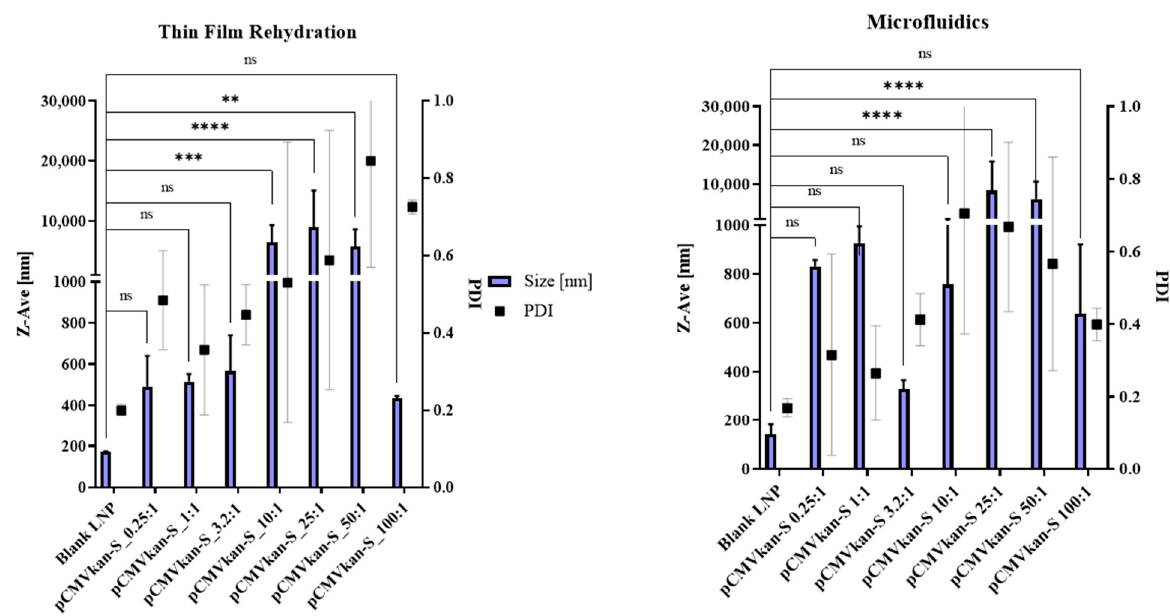
Figure 4. Size and size distribution of DOTAP4/pCMVkan-S complexes at different N/P ratios. Left graph shows the results obtained with thin-film layer rehydration-manufactured liposomes. Right graph shows the results obtained with microfluidics-manufactured liposomes. Data are represented as mean ± SD ( n = 3). **** indicate p < 0.0001, *** p < 0.001, ** p < 0.01, ns shows non-significance when comparing sizes of liposomes complexed with DNA to blank particles. Table 1. Lipoplex characteristics and summary of statistical analysis between same N/P ratios for- mulated with MF vs. TF particles. 1 The test performed is an unpaired Welch’s t -test. **** indicate p < 0.0001, *** p < 0.001, ** p < 0.01, ns shows non-significance.